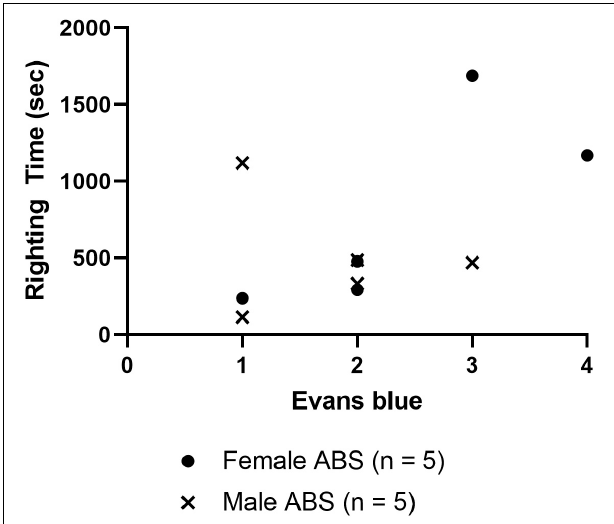
FIGURE 7 | Correlation of righting reflex time and Evans blue staining 4 h post-injury. The scatterplot displays the righting time of injured male and female mice 4 h after shock wave exposure with respect to the amount of Evans blue staining intensity ranked 1 (least) –4 (most), and Kendall tau analysis indicated a significant correlation between stain intensity and the duration of the righting reflex ( τ = 0.508, p = –0.030). No correlations (data not shown) were detected between Evans blue ranking and peak ABS pressure ( τ = –0.025, p = 0.925), Evans blue and body weight ( τ = 0.090, p = 0.719), righting time and peak pressure ( τ = 0.244, p =